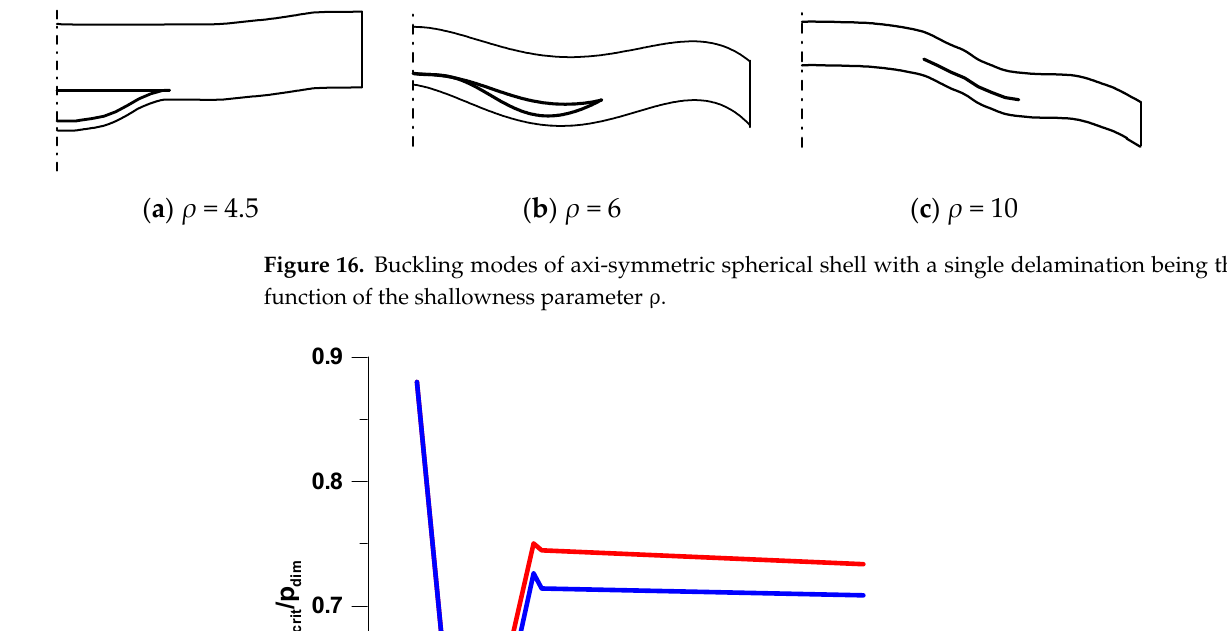
Figure 15. Distributions of the strain energy release rates G I for various shallowness parameter ρ .